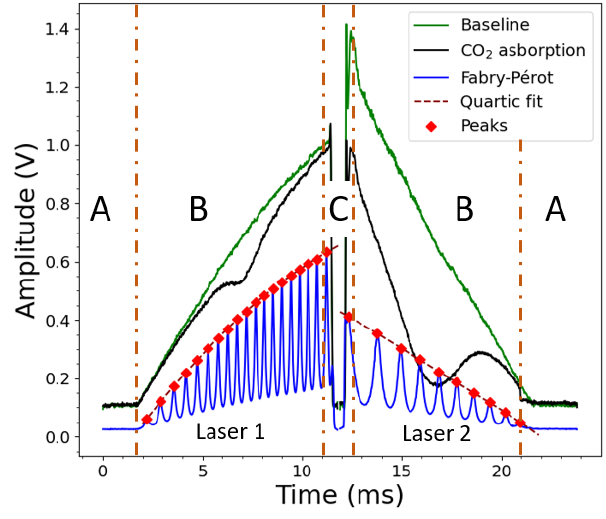
Figure 4. Example of data recorded by Laser 1 @2.004 µm and Laser 2 @2.682 µm in one modulation time period. The black and green solid lines are the baseline and the CO 2 absorption raw signals, respectively, recorded by the photodiode along the experimental path. The blue solid line is the Airy’s function signal obtained through the (FP) etalon. The red diamonds are the peaks found with the FP signal to achieve a wavenumber scale thanks to a fourth-degree polynomial function (quartic fit), shown as a red dotted